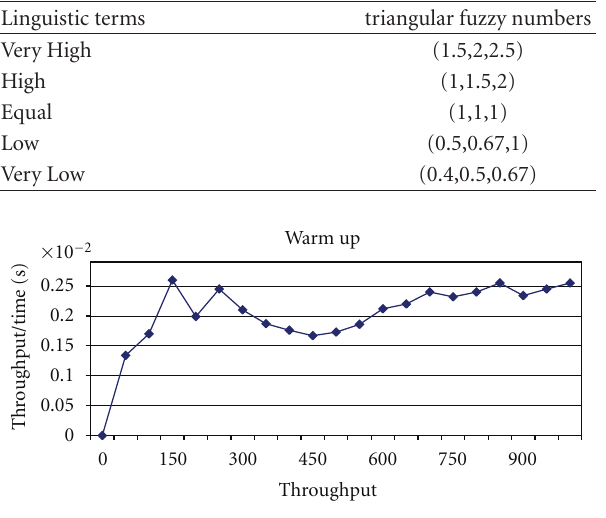
Figure 5: The warm-up diagram.